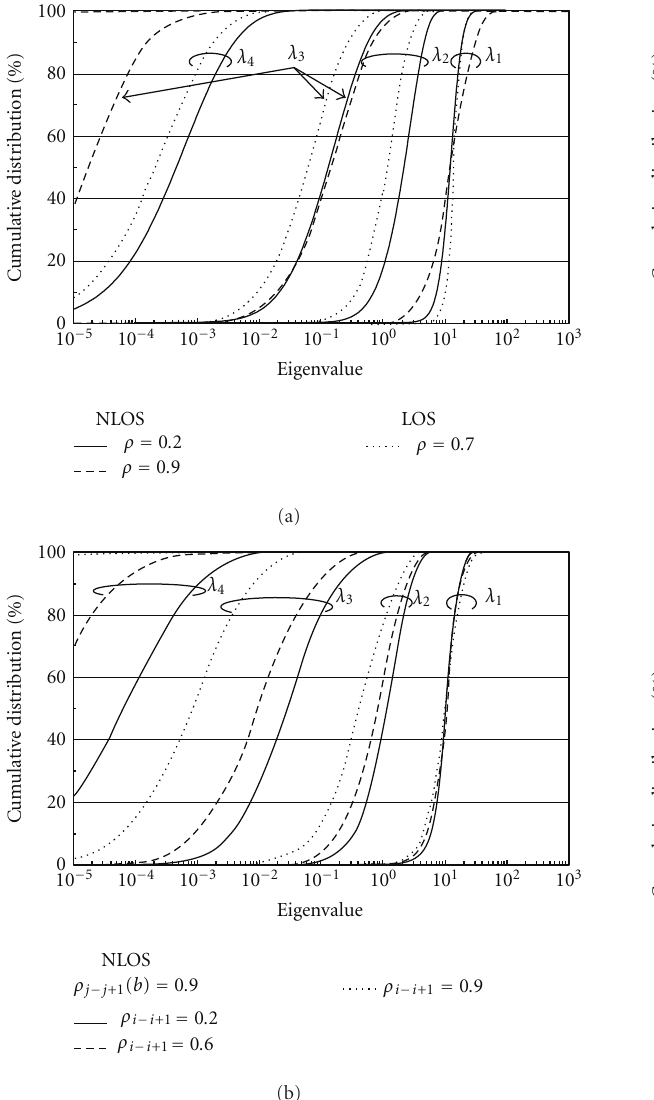
Figure 8: Dependence of eigenvalue on correlation (4 × 4 MIMO). (a) Uniform-uniform distribution. (b) Uniform-Gaussian distribu- tion.